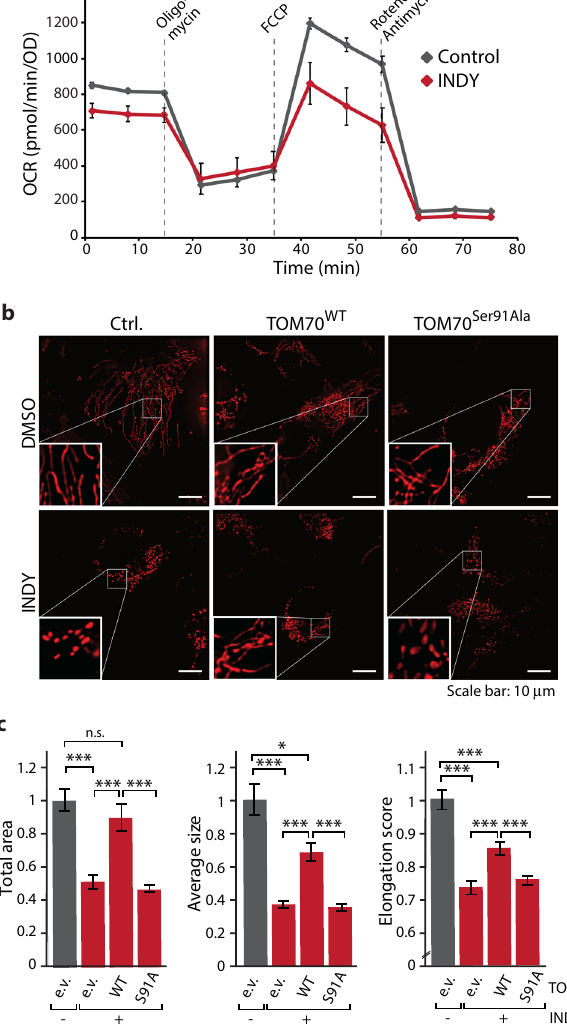
Fig. 2 Inhibition of DYRK1A activity in vivo affects function and morphology of mitochondria. a Analysis of oxygen consumption rates (OCR) of cells treated with INDY (10 μ M) at basal conditions and after addition of indicated compounds. Control cells were incubated in parallel in the presence of the respective volume of DMSO. Data represent means ± SEM from six independent experiments. b U2OS cells cultured on glass bottom plates were treated with 10 μ M INDY or DMSO as control for 24 h and stained with MitoTracker Red CMXRos. Where indicated cells were transfected with TOM70 WT and TOM70 Ser91Ala overexpression plasmids. Each microscopy image includes a magni fi ed inset. Scale bar: 10 μ m. c Total mitochondrial area, average size and elongation of the samples from b were measured. Data were normalized to the respective DMSO control and shown as means± SEM ( n = 20 cells). Statistical analysis was performed using a one-way ANOVA followed by a Bonferroni post-hoc test to allow multiple comparisons. Signi fi cances are indicated with asterisks: *** p < 0.001, ** p < 0.01, * p < 0.05, not signi fi cant (n.s.) p > 0.05. Numerical source data are reported in the Source Data